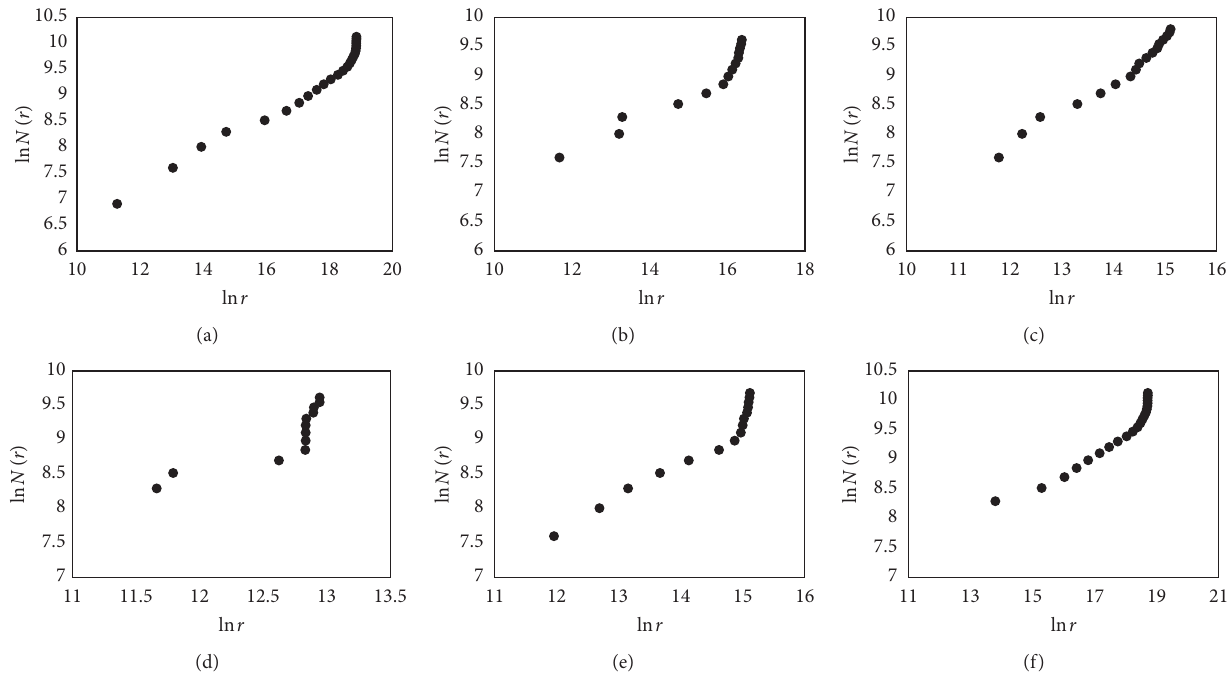
Figure 5: Bilogarithmic plots of various types of green space estimated by using the radius dimension. (a) G , (b) G 1, (c) G 2, (d) G 3, (e) G 4, and (f) G 5.